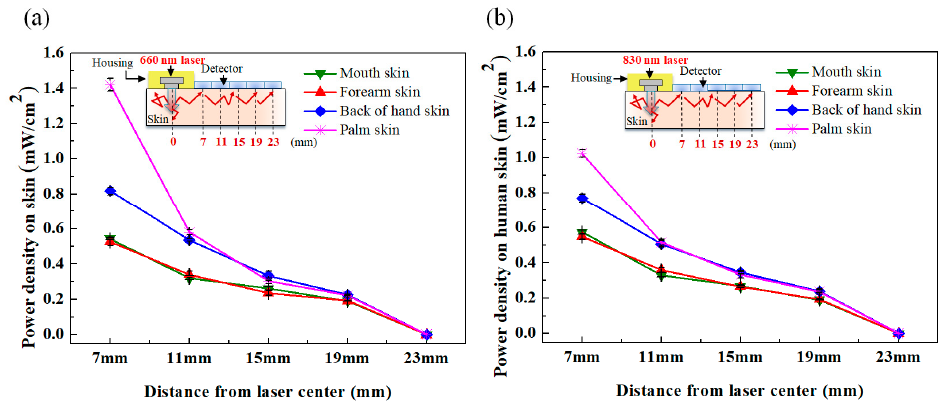
Figure 4. Backscattering of ( a ) 660 nm and ( b ) 830 nm lasers on different skin areas.